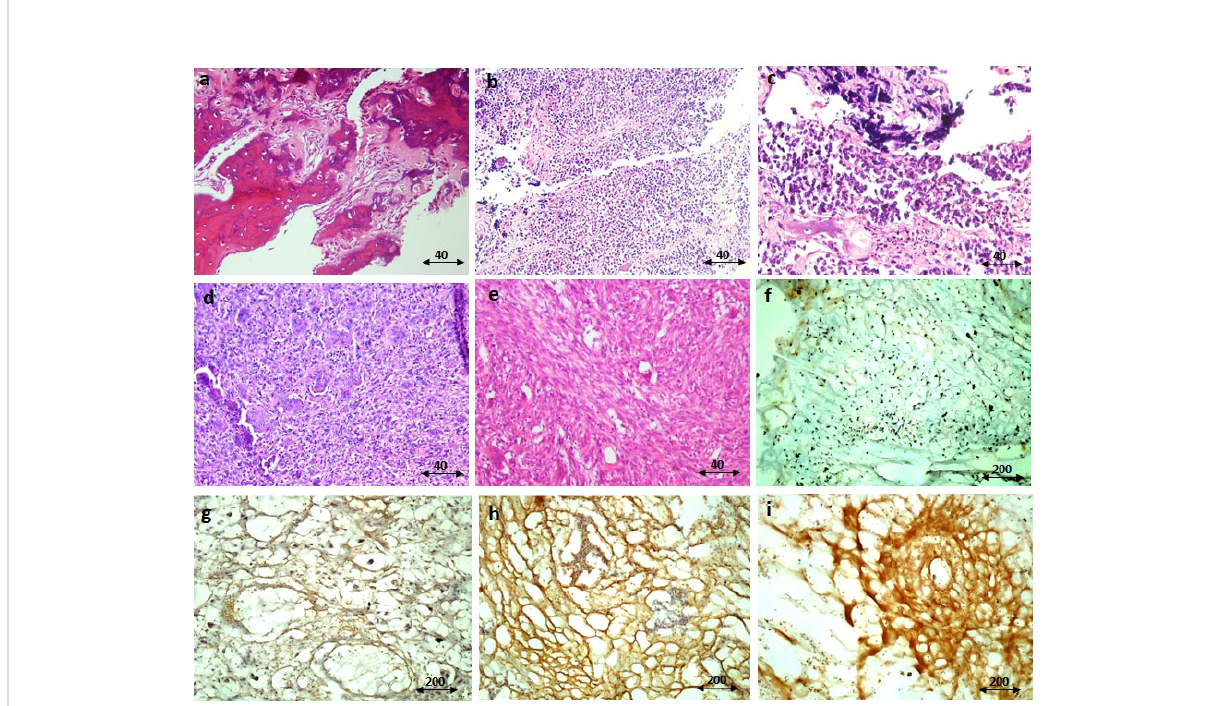
FIGURE 3 The immunohistochemistry staining of IGF-1R protein. The representative images for hematoxylin and eosin (H&E) staining of the osteosarcoma tumor tissue (A) , Ewing sarcoma (B, C) , and GCT (D, E) are shown. The negative immunereactivity of IGF-1R using immunohistochemistry is shown (F) . The weak staining intensity (G) , the moderate intensity (H) , and the strong intensity (I) of IGF-1R staining are shown. The scale of magni fi cation for (A-E) is 40 and for (F-I) is